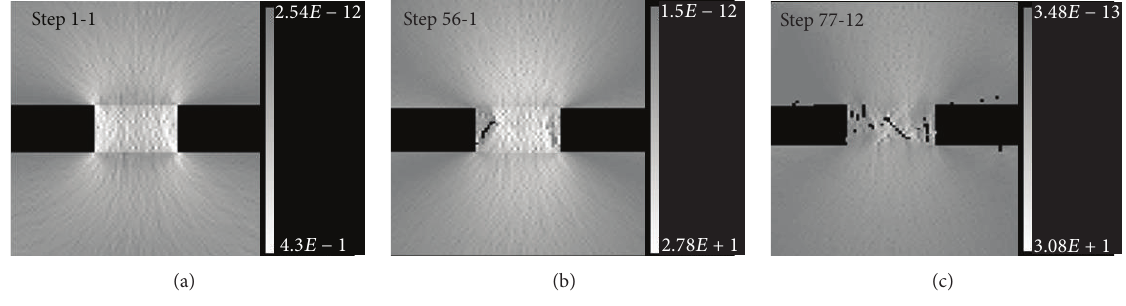
Figure 15: Plot of shear stresses around a pillar with width-to-height ratio =